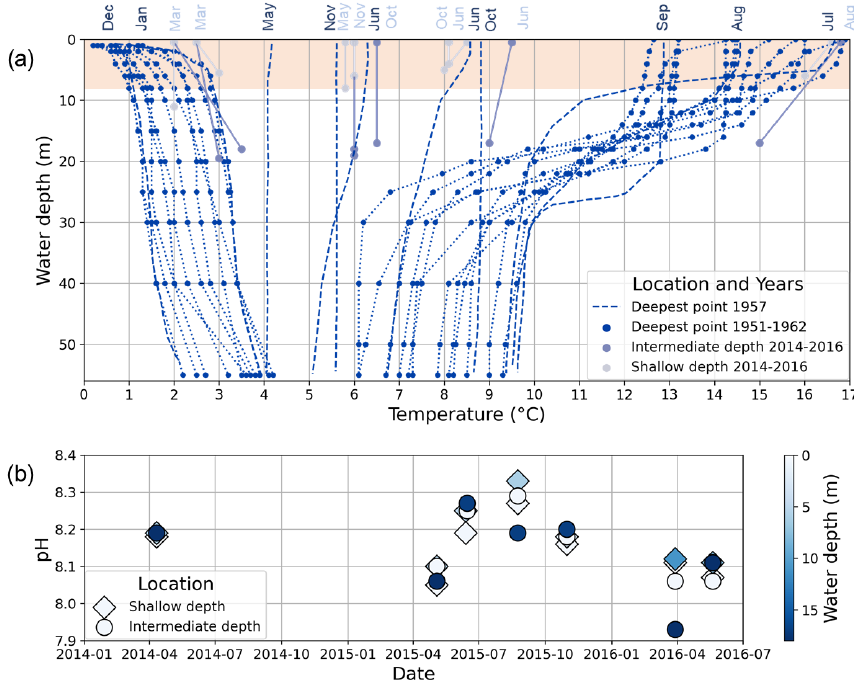
Figure 3. (a) Water temperature profiles from Lake Locknesjön. Dark blue dots represent measurements taken between 1951 and 1962, two times per year approximately at the time when the water was coldest during winter (February–March) and warmest during summer (August). Profiles extend from the surface to the bottom at the lake’s deepest point. The dashed lines show measurements taken at the same point throughout the year 1957 in the indicated months (data from Eklund, 1998). Other dots represent measurements taken between 2014 and 2016 from surface and bottom water at two sites of shallow ( < 11m, light blue dots) and intermediate ( < 20m, light gray dots) water depth (data from the Triple Lakes Project, http://www.triplelakes.se/, last access: 16 February 2021). Dotted and solid lines connect measurements taken from different depths at the same location and on the same day. The shaded area marks the water depths from which carbonate samples were taken. (b) pH measured in surface and bottom water at two sites of shallow and intermediate depth between 2014 and 2016 (data from the Triple Lakes